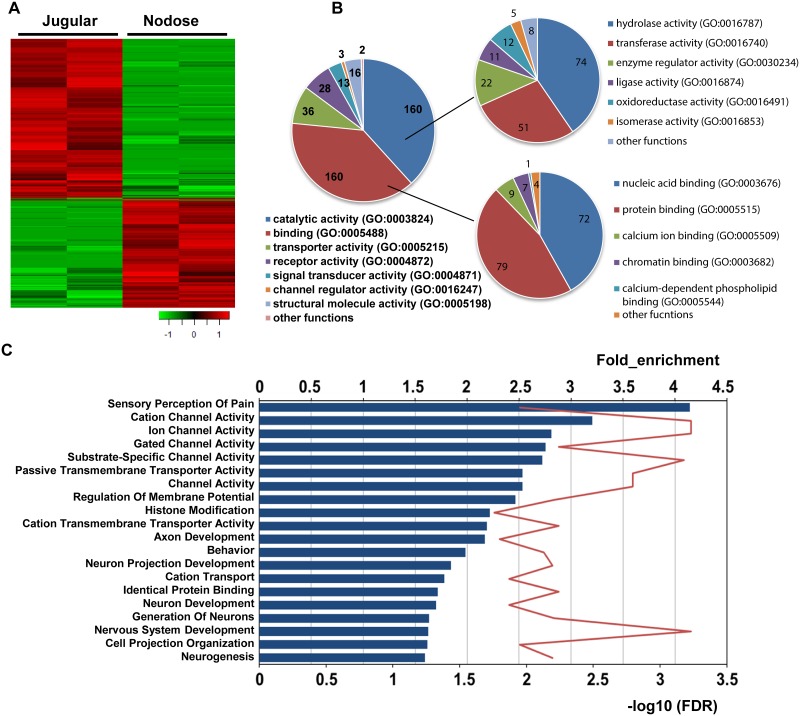
RNA sequencing revealed distinct gene expression between nodose and jugular C-fiber neurons.(A) Heatmap showing expression of genes with significant expression difference between nodose and jugular C-fiber neurons. Log2 transformed CPM was used. Red indicates high expression, green indicates low expression. Color bar indicates z score. (B) Pie plot showing functional annotation of genes with significant expression difference between nodose and jugular C-fiber neurons. The number of genes in each category is indicated. (C) Top 20 Gene Ontology (molecular function and biological process) pathways enriched for genes with significant expression difference between nodose and jugular C-fiber neurons. Pathways are ranked by fold of enrichment. Blue bar and upper horizontal axis indicate fold of enrichment; red line and lower horizontal axis indicate–log10 (FDR). Data from TRPV1 selection dataset.